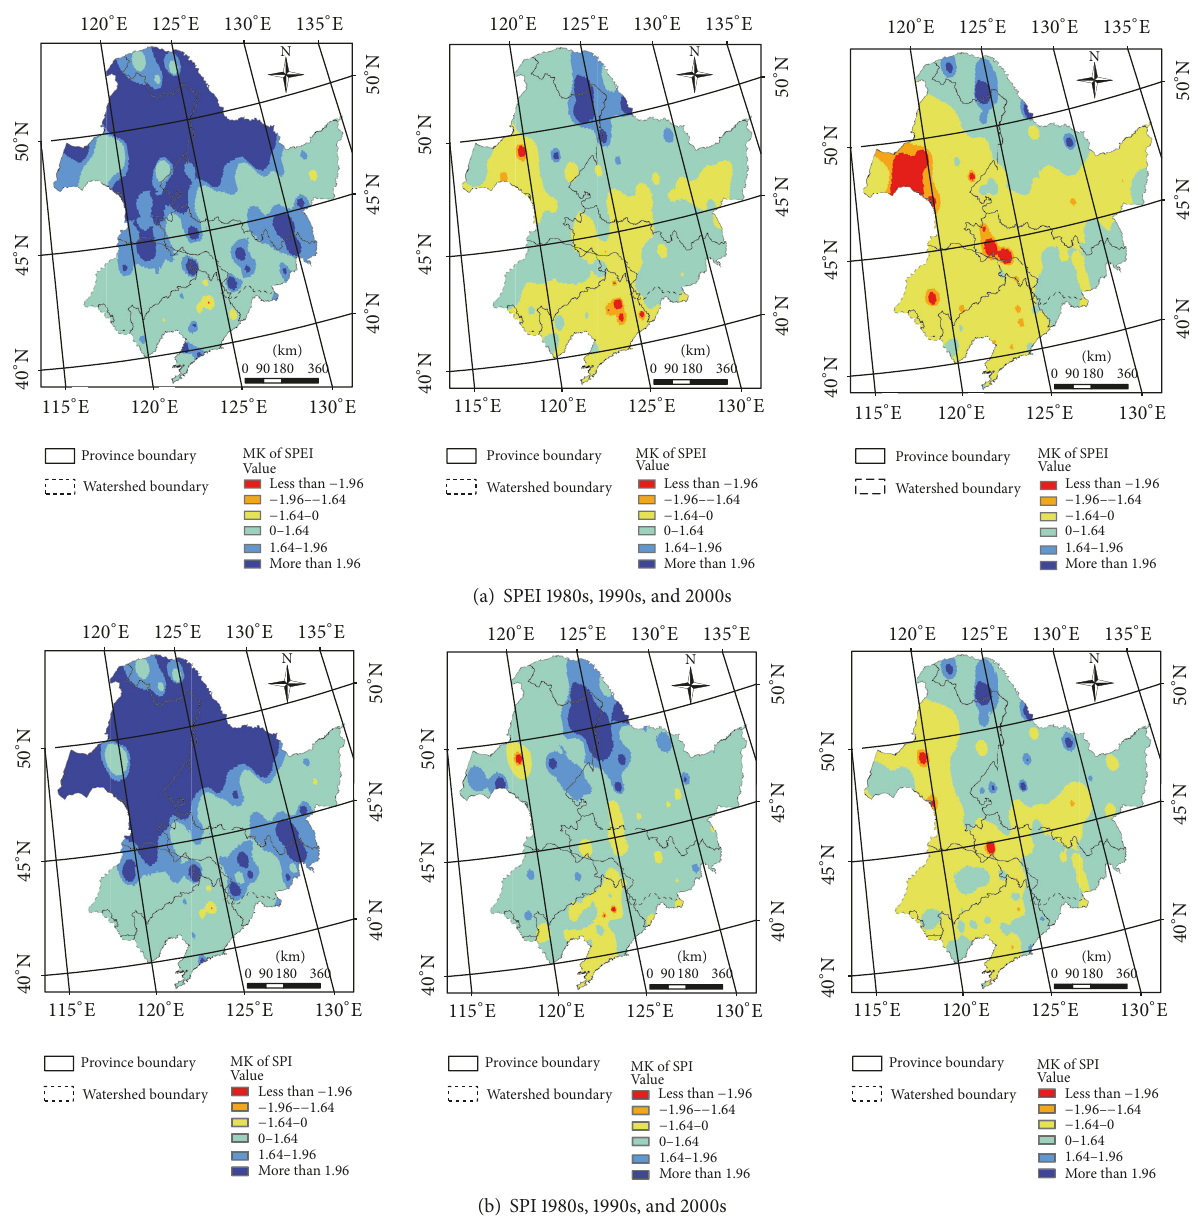
Figure 8: Trend variations of (a) annual SPEI and (b) annual SPI over SLRB from the 1980s through the 2000s.